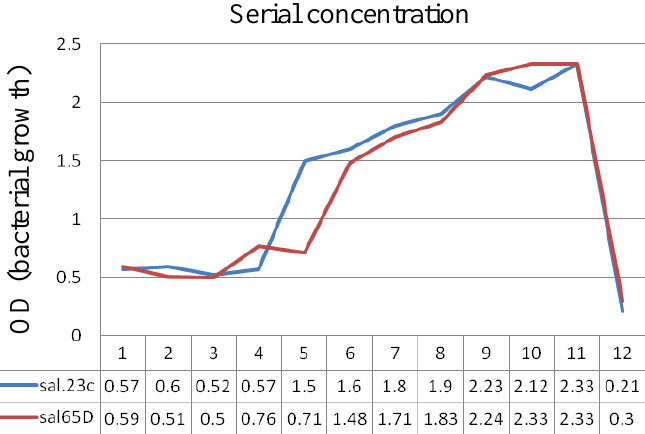
Figure 3. The results of minimum inhibitory concentration(MIC) determined by microdilution method (OD versus concentrations) for two salmonella strains. Concentrations of A. littoralis extract in wells 1 – 12were 4, 2, 1, 0.5, 0.25, 0.125, 0.062, 0.031, 0.015, and 0.007 mg/mL, respectively ( wells 11 and 12 were controls).